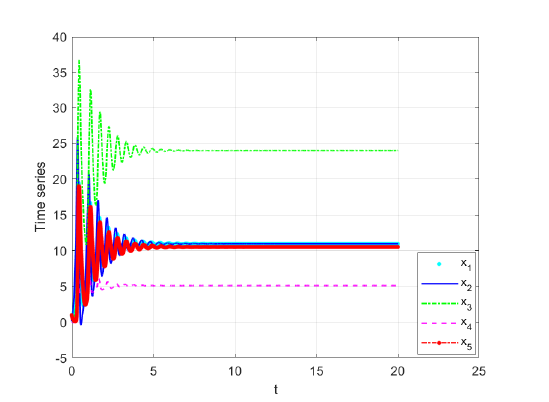
, r = 25, d = 19 , and α = 3 3